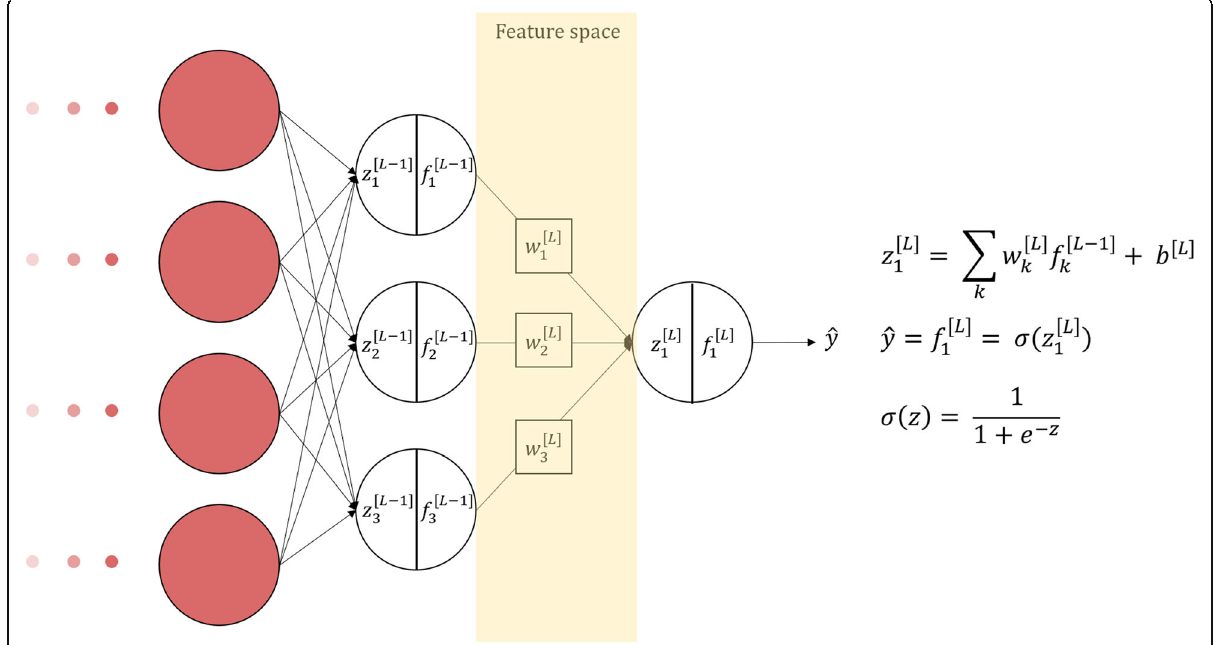
Fig. 2 The L and L-1 layers of a deep neural